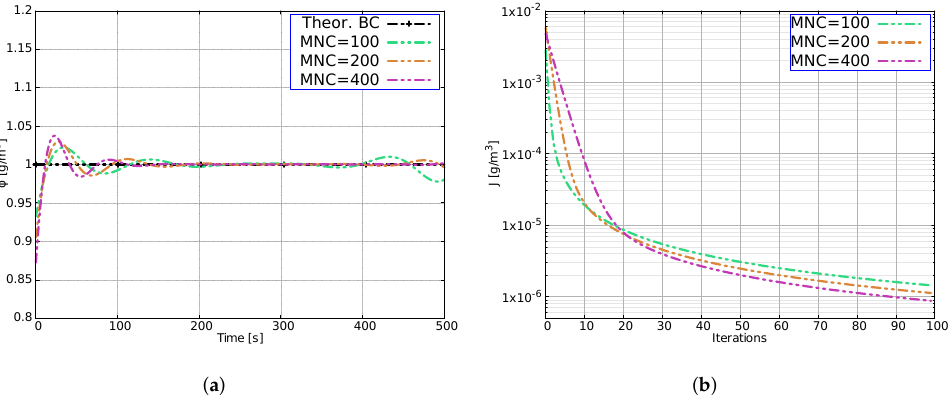
Figure 6. Case 1. Reconstruction of the boundary condition at iteration 100 ( a ) and evolution of the objective function at each iteration ( b ) for different number of